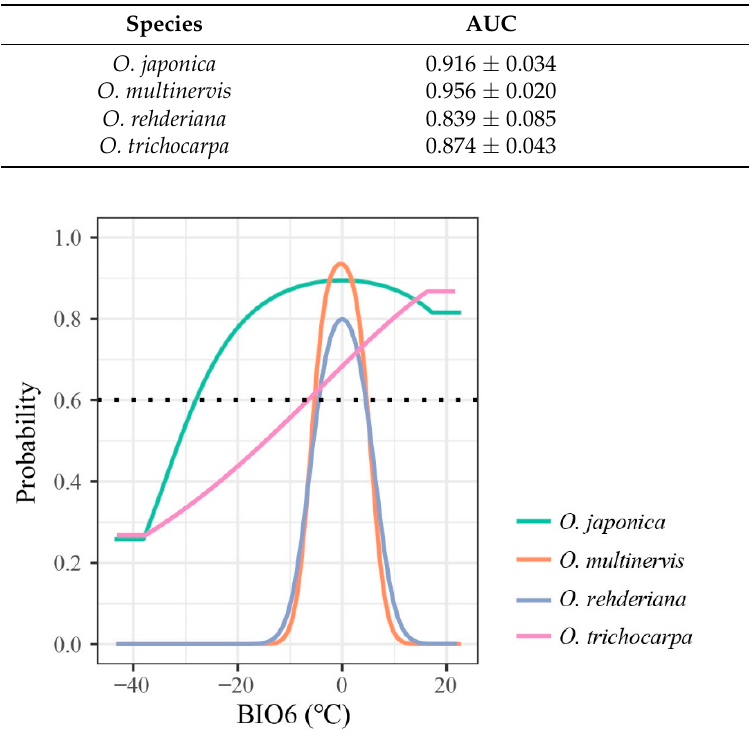
Figure 2. Response curves of four Ostrya species, i.e., O. japonica , O. multinervis , O. rehderiana , and O. trichocarpa , presence probability affected by BIO6 (minimum temperature of coldest month, °C). The black dotted line represents that the probability of species existing is 0.6; species would archive high potential adaptation above this line.